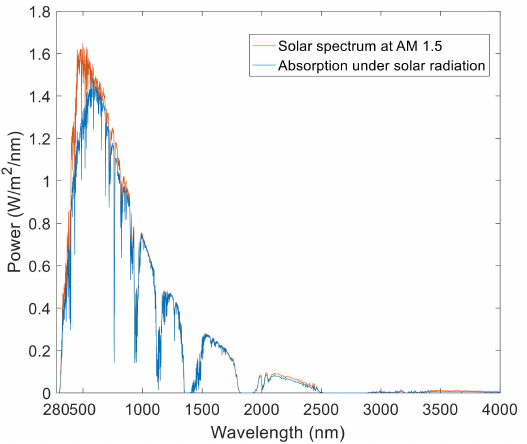
Figure 8. Solar spectrum at air mass (AM) 1.5 and absorption spectrum of the ultra-broadband perfect